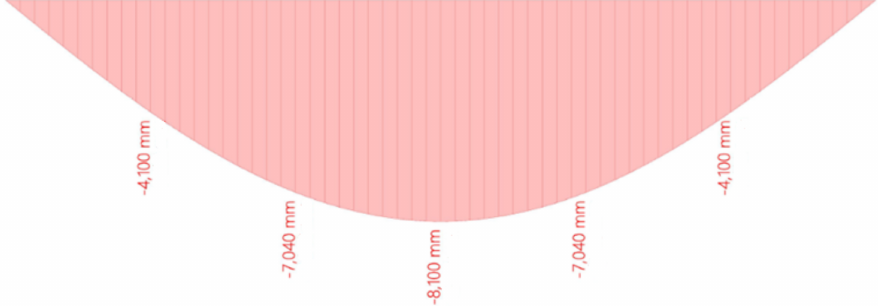
Figure 13. Results of the static analysis of vertical displacements of the beam TO_01.